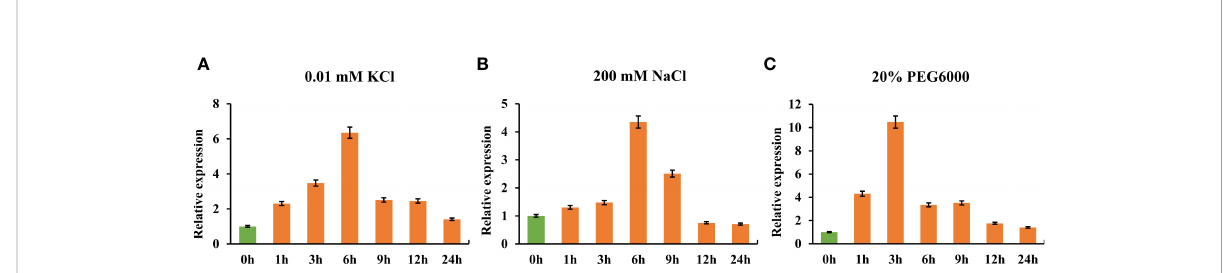
FIGURE 1 Real-time quantitative PCR expression of TaHAK13 in wheat roots under different stresses. (A) The relative expression of TaHAK13 under low potassium stress (0.01 mM KCl). (B) The relative expression of TaHAK13 under salt stress (200 mM NaCl). (C) The relative expression of TaHAK13 under dehydration stress (20% PEG6000). The relative expression of TaHAK13 at 0 h was taken as a value of